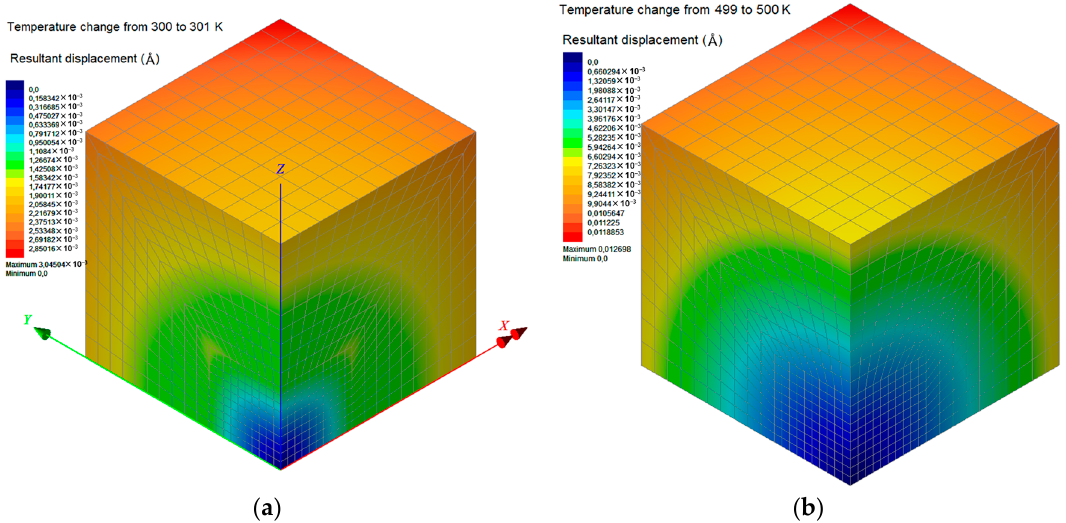
Figure 16. Contours of the resultant displacement of the nanocomposite RVE with a mass fraction with w C240 = 0.01, for a temperature change ( a ) from 300 to 301 K and ( b ) from 499 to 500 K.